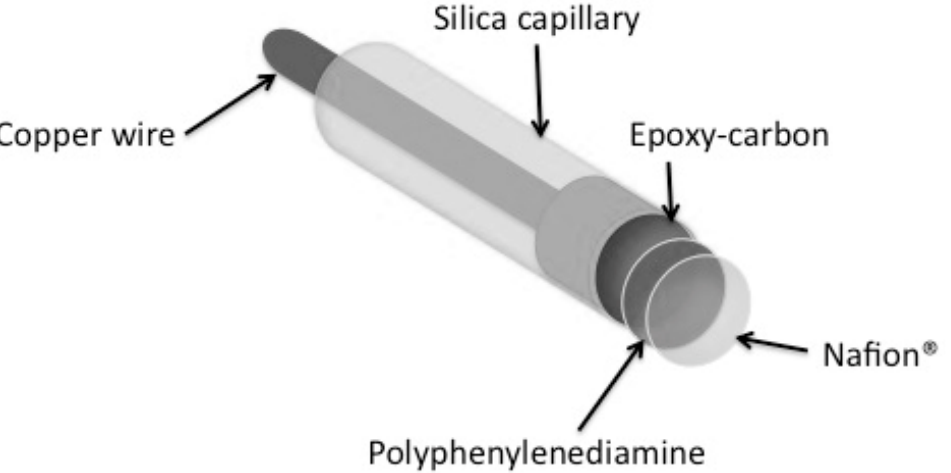
Figure 10. Scheme of NO microsensor. The active surface is a 180 μ m diameter epoxy-carbon disk. The disk surface is then modified with p-OPD and Nafion ® to ensure selectivity of the sensors for NO.